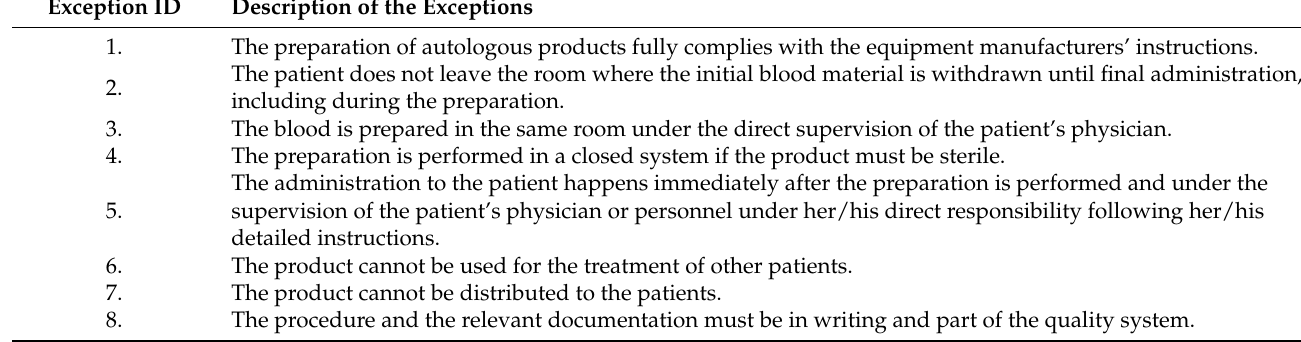
Table 1. Exceptions to new rulings on the authorization requirements for PRP manufacture in Switzerland, in the case where the criteria are respected (e.g., the physician must ensure the safety, quality, and efficacy of the treatment). PRP, platelet-rich plasma.